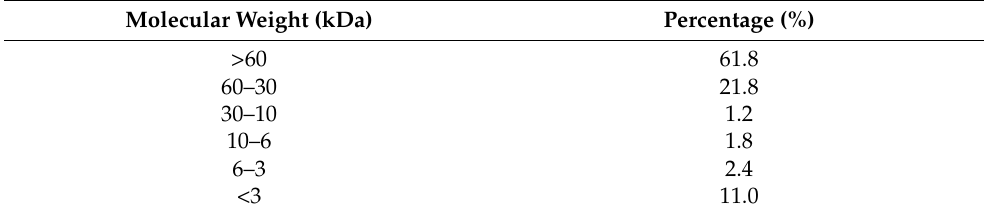
Table 3. Size distribution of alkali lignin at pH 11. Reproduced with permission from